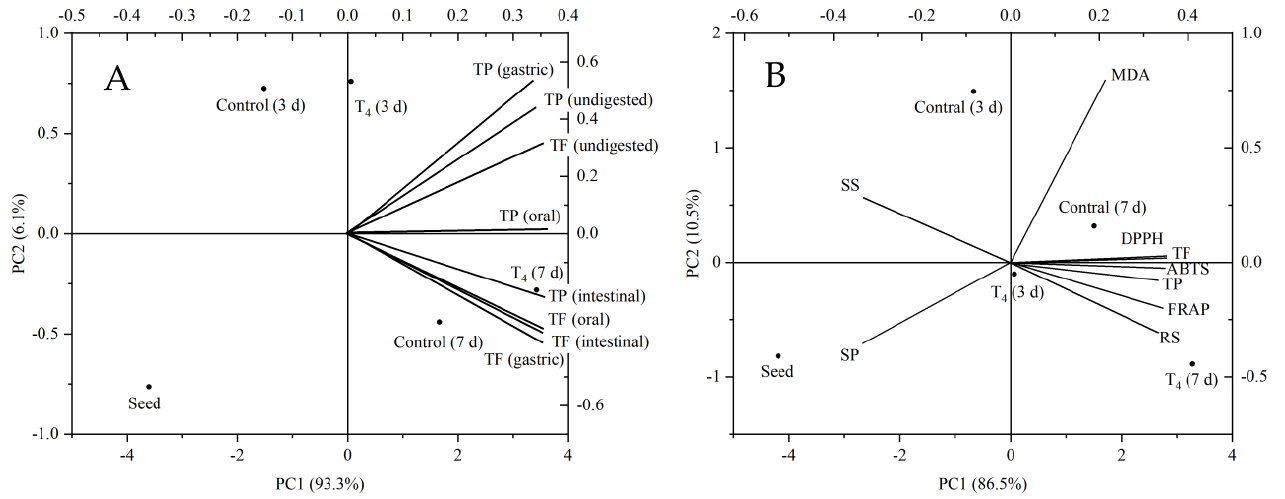
Figure 6. Component plot of main active components (PCA), TF, TP and antioxidant activity before and after digestion on TB seed and sprouts. SS, soluble sugar; SP, soluble protein; RS, reducing sugar. ( A ) PCA of TF and TP before and after digestion on TB sprouts; ( B ) PCA of antioxidant activity and active components on TB sprouts.